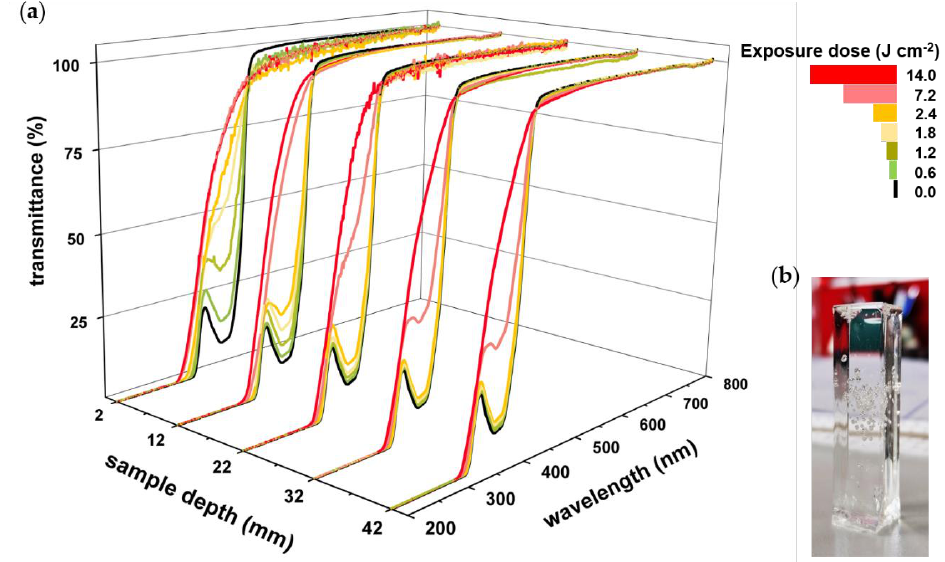
Figure 7. ( a ) Sample depth-dependent photobleaching of TPO-L in a bulk formulation